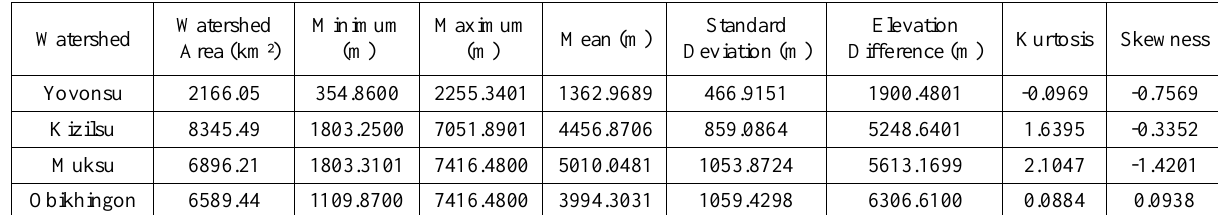
Table 1. The basic geographic attributes